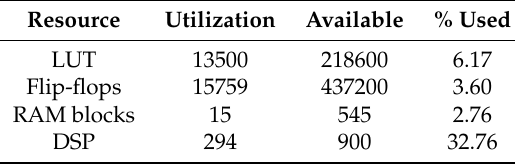
Table 2. Postimplementation resources report (Xilinx